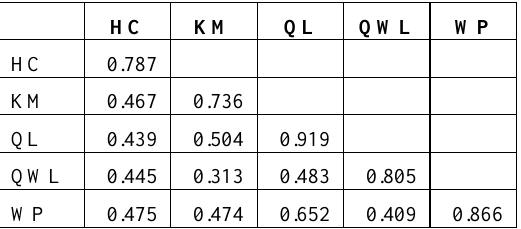
Table 9: Fornell and Larker Criterion for Higher- Order Constructs